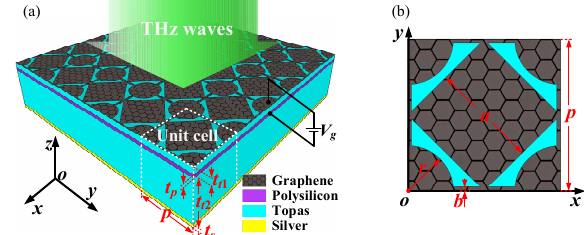
Figure 1. ( a ) Schematic of the proposed tunable polarization-insensitive broadband terahertz absorber, which is a multilayer structure with a single-layer patterned graphene-dielectric spacer-gating layer-dielectric spacer-metallic reflecting plate from the top to the bottom; ( b ) Top view of the absorber unit cell. The graphene layer has a periodically arranged hybrid square/disk/loop structure for electric-continuity and gating convenience, and the dimensions of the absorber are set as p = 40 μm, a = 20 2 μm , r = 11 μm, b = 250 nm, t g = 0 nm, t t 1 = 20 nm, t p = 20 nm, t t 2 = 20.96 μm, t s = 500 nm.